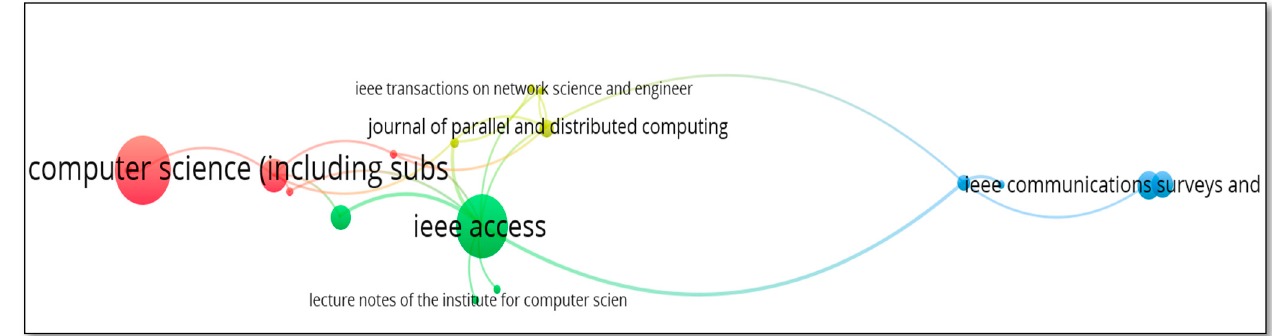
Figure 15. Citation Analysis of Source. Table 11. Links, TLS, documents and citations for citation analysis